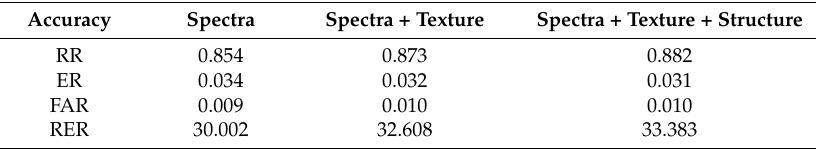
Table 6. RR, ER, and RER with different features combination.